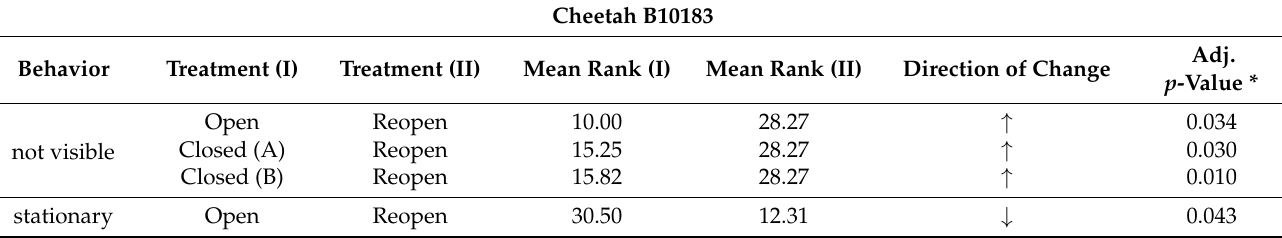
Table 6. Significant ( α = 0.95) results of the behavior engagement analysis for cheetah based on the Zoo’s opening status. Pairwise comparisons (Dunn 1984) were conducted on significant results from Kruskal–Wallis (H) tests. Asterisks ( * ) indicate adjusted p -values (Bonferroni correction for multiple